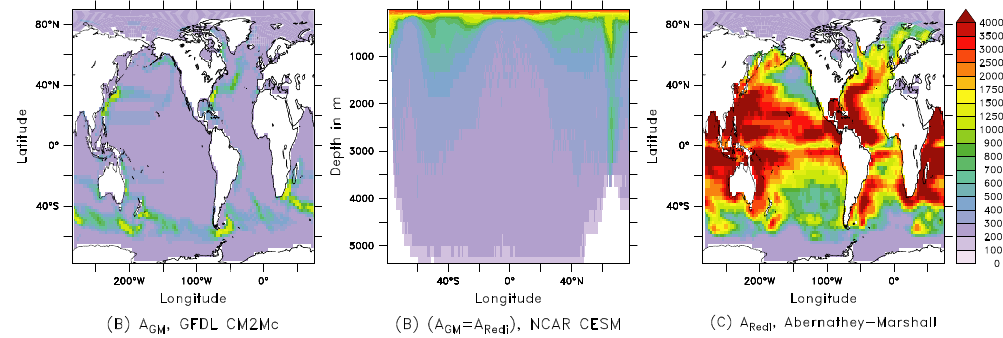
Figure 2. Examples of A GM and A Redi . (a) Vertically uniform A GM from Galbraith et al. (2011). (b) Horizontal average of A Redi = A GM from Danabasoglu et al. (2012). (c) Surface A Redi from observationally based calculation of Abernathey and Marshall